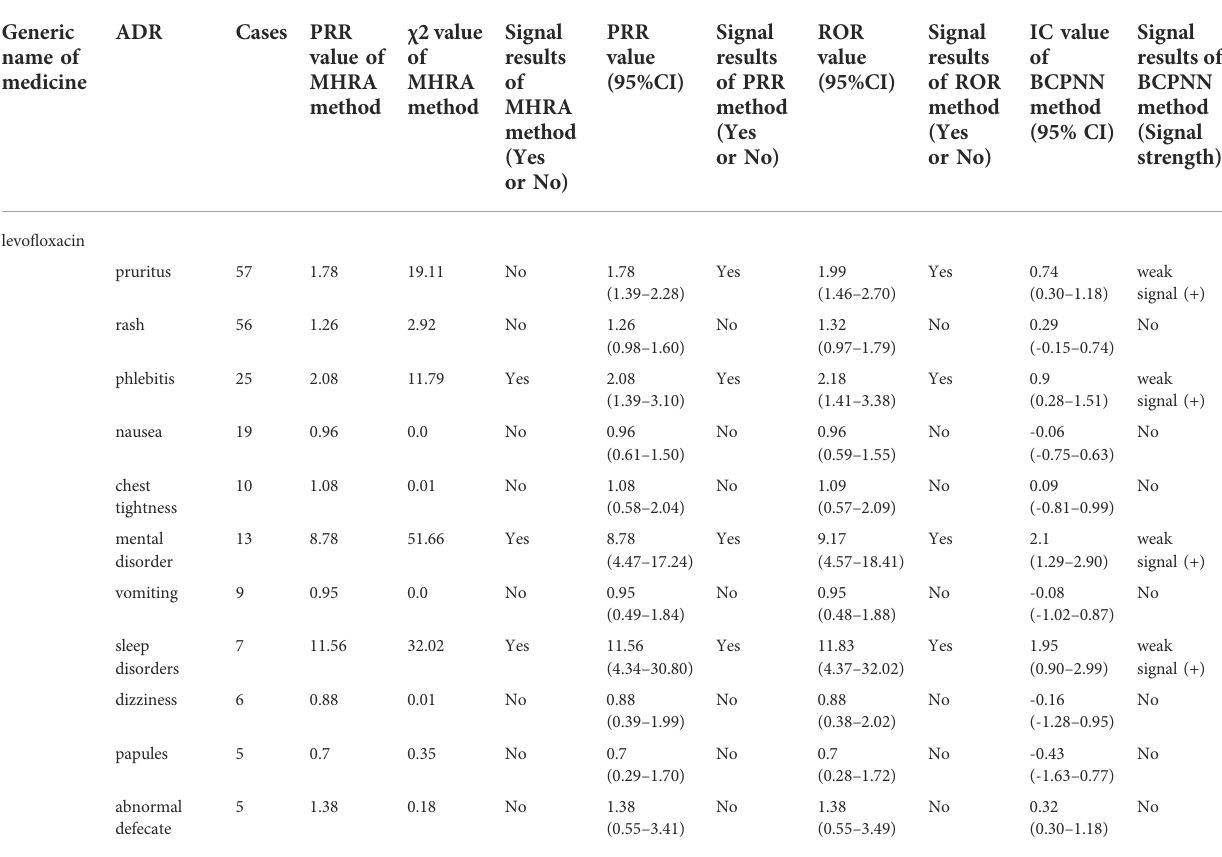
TABLE 5 Comparison of various signal detection methods (Drug-Adverse